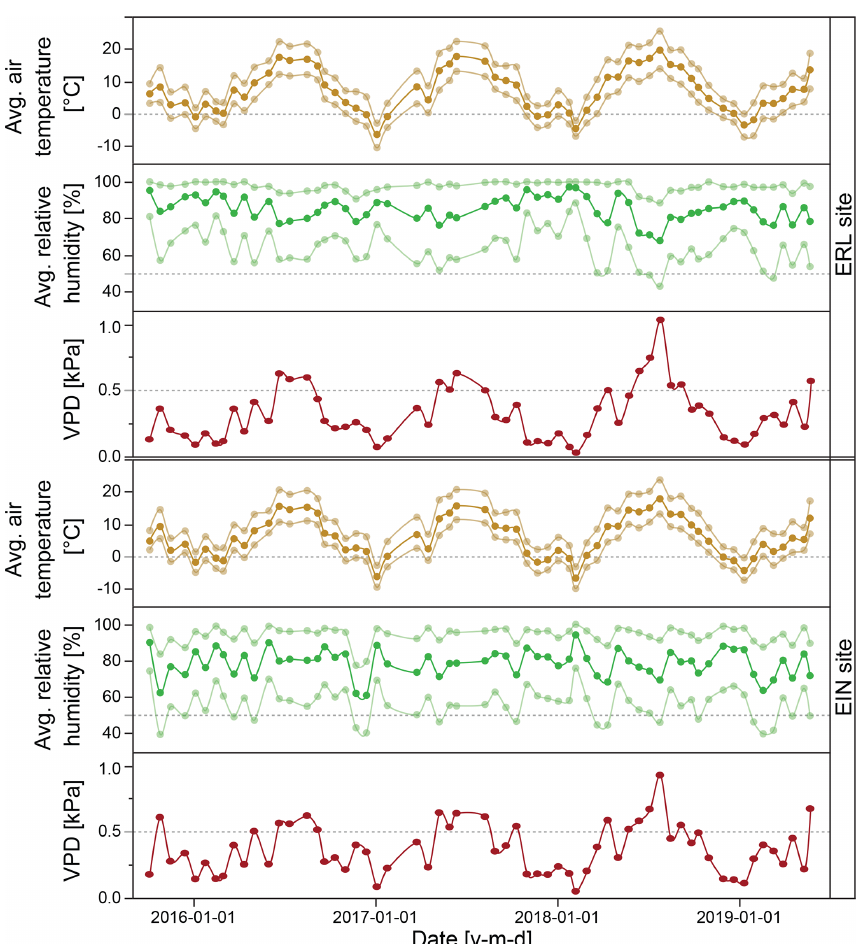
Figure 6. Mean, minimum, and maximum values of air temperature and relative humidity, as well as vapor pressure deficit (VPD), averaged over 2–3-week storage periods during Experiment 3 at the two field sites EIN and ERL. Dashed horizontal lines in each panel indicate 0 ◦ C air temperature, 50% relative humidity, and 0.5kPa VPD for easier comparison between